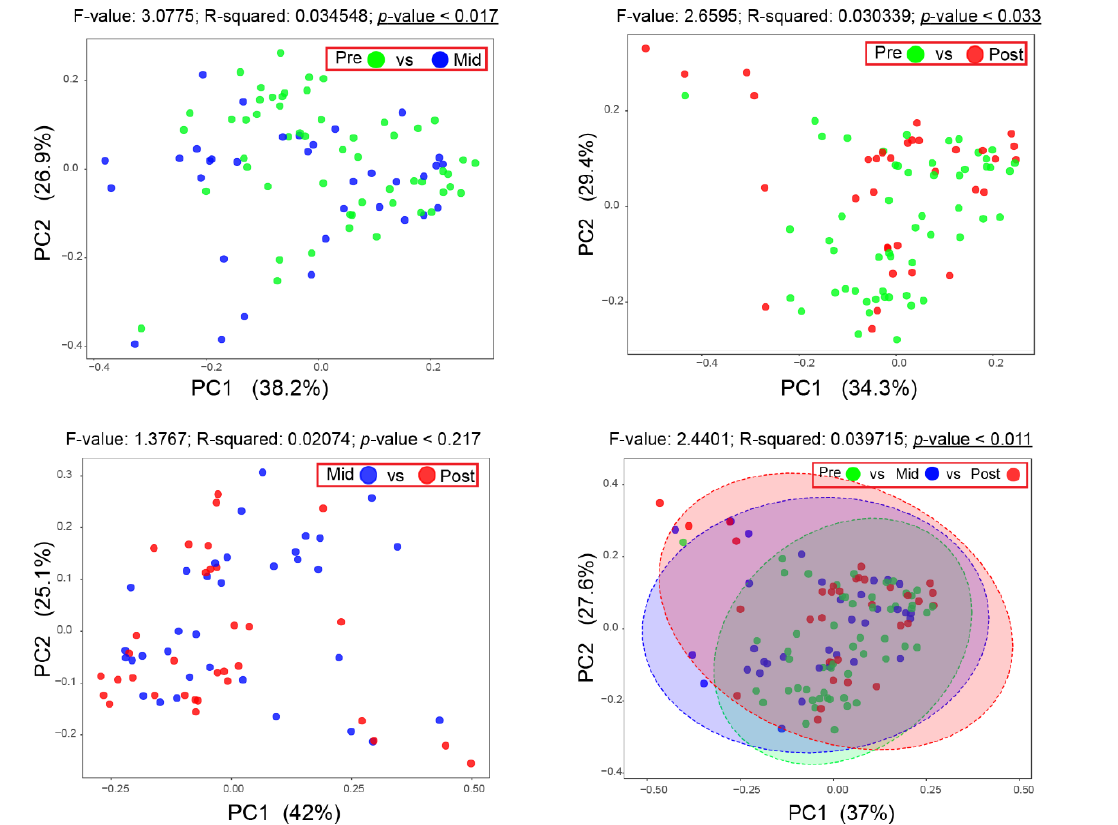
Figure 4. Principle coordinates analysis (PCoA) plots of all oral microbiome samples based on weighted Unifrac distance. Two-dimensional PCoA plots represent the variation between oral microbiome samples in the dataset as follows (Pre-RT vs. Mid-RT, Pre-RT vs. Post-RT, Mid-RT vs. Post-RT and all the three groups Pre-RT vs. Mid-RT vs. Post-RT). Distances between points on the plot represent how similar samples are in terms of microbiota composition and relative abundance. Therefore, points in the plot that are closer in space are more similar in their taxonomic distribution. Significance differences in the β -diversity were observed for all tested groups except Mid vs. Post. Underlined p values indicate statistical significance ( p < 0.05). PC1 and PC2 explained 37% and 27% of the variance. Significance was assessed using PERMANOVA.